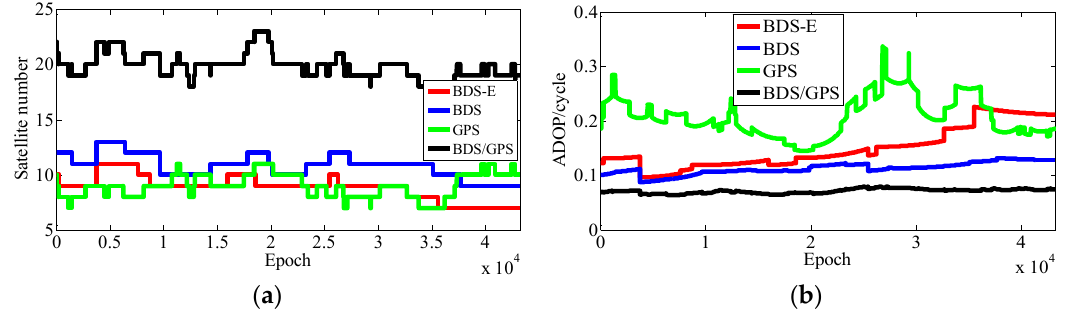
Figure 11. Satellite number and ADOP of four systems for group A. ( a ) The satellite number of four systems for group A. ( b ) The ADOP of four systems for group A.